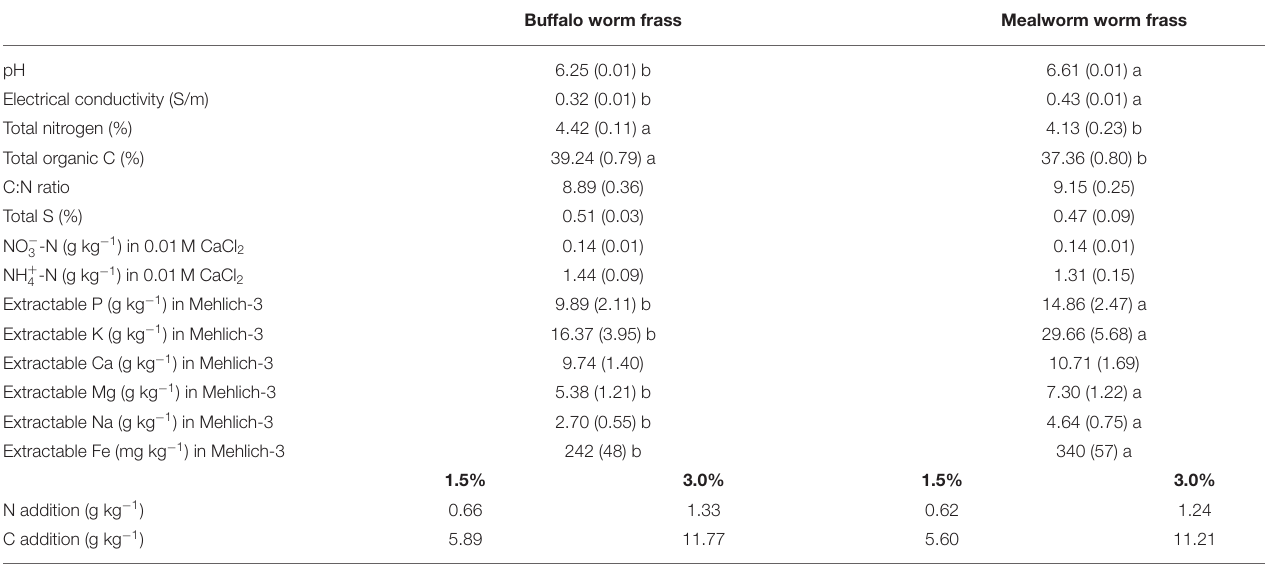
TABLE 1 | Chemical composition of frass types and added amounts of N and C (mean ± standard deviation for n =